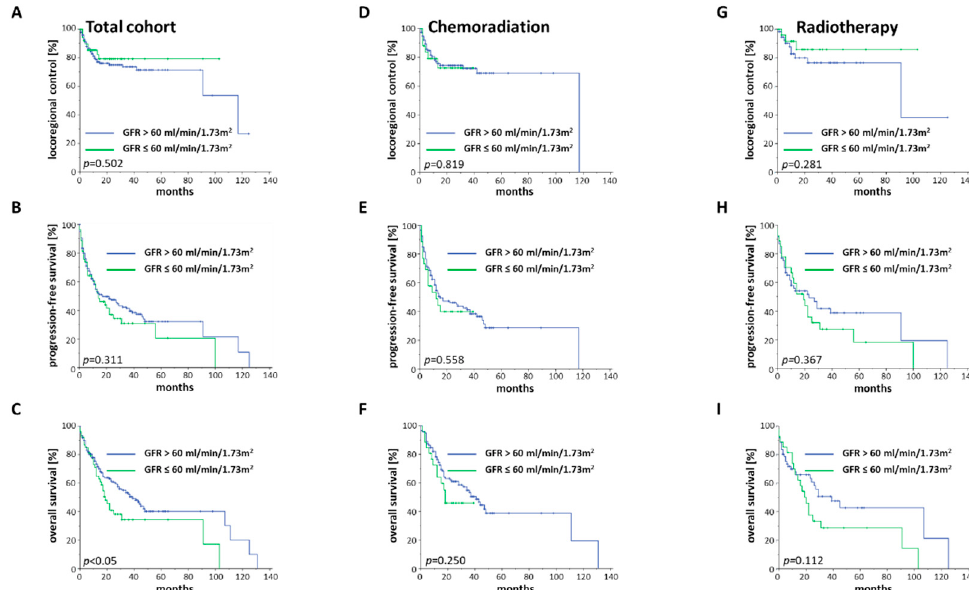
Figure 3. LRC, PFS and OS of elderly HNSCC patients stratified by the baseline GFR value. ( A – C ) Kaplan–Meier curves for the entire cohort with existing GFR values ( n = 234). ( D – F ) Kaplan–Meier curves consisting of all patients who received chemoradiation and had accessible GFR values ( n = 146). ( G – I ) Kaplan–Meier curves showing all patients who were treated with radiotherapy and had available GFR levels ( n = 88). Log-rank tests were performed for comparisons.